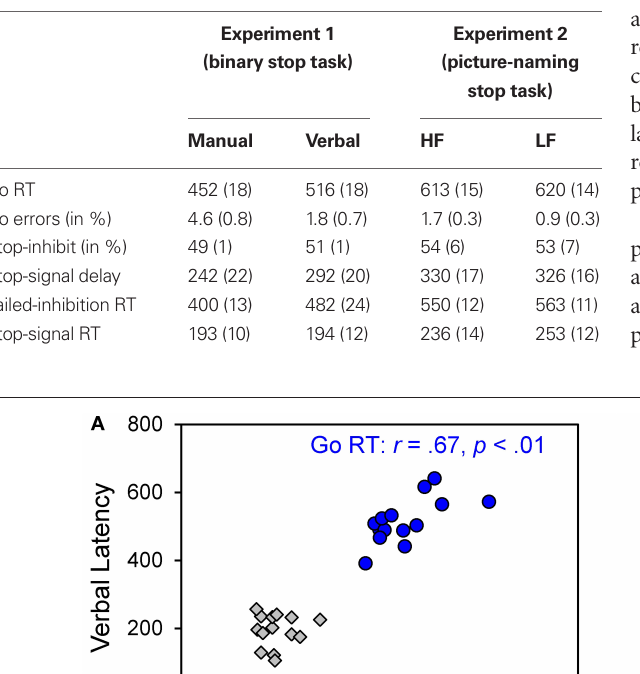
Table 1 | Mean go rT and error Percentages on go trials, Percentage of Stop-inhibit Trials, Stop-Signal Delay, Failed-inhibition rT, and Stop- Signal rT in the Binary Manual and Verbal Stop Tasks (experiment 1) and in the High-Frequency (HF) and Low-Frequency (LF) Conditions of the Picture-Naming Stop Task (experiment 2). SEM in parentheses.